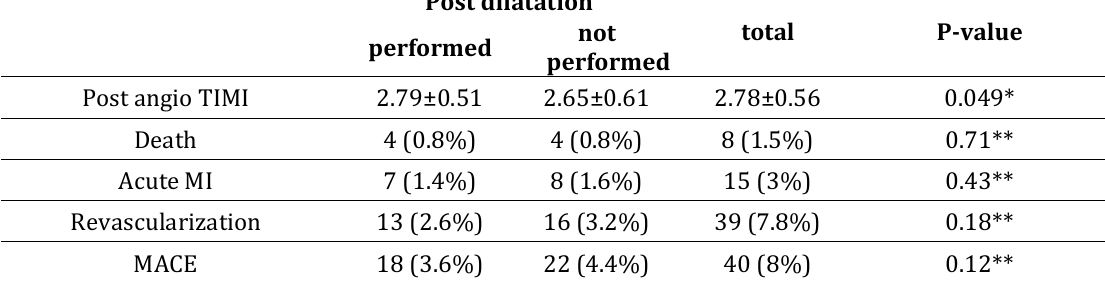
Table 3. Post-interventional outcomes and complications according to post-dilatation